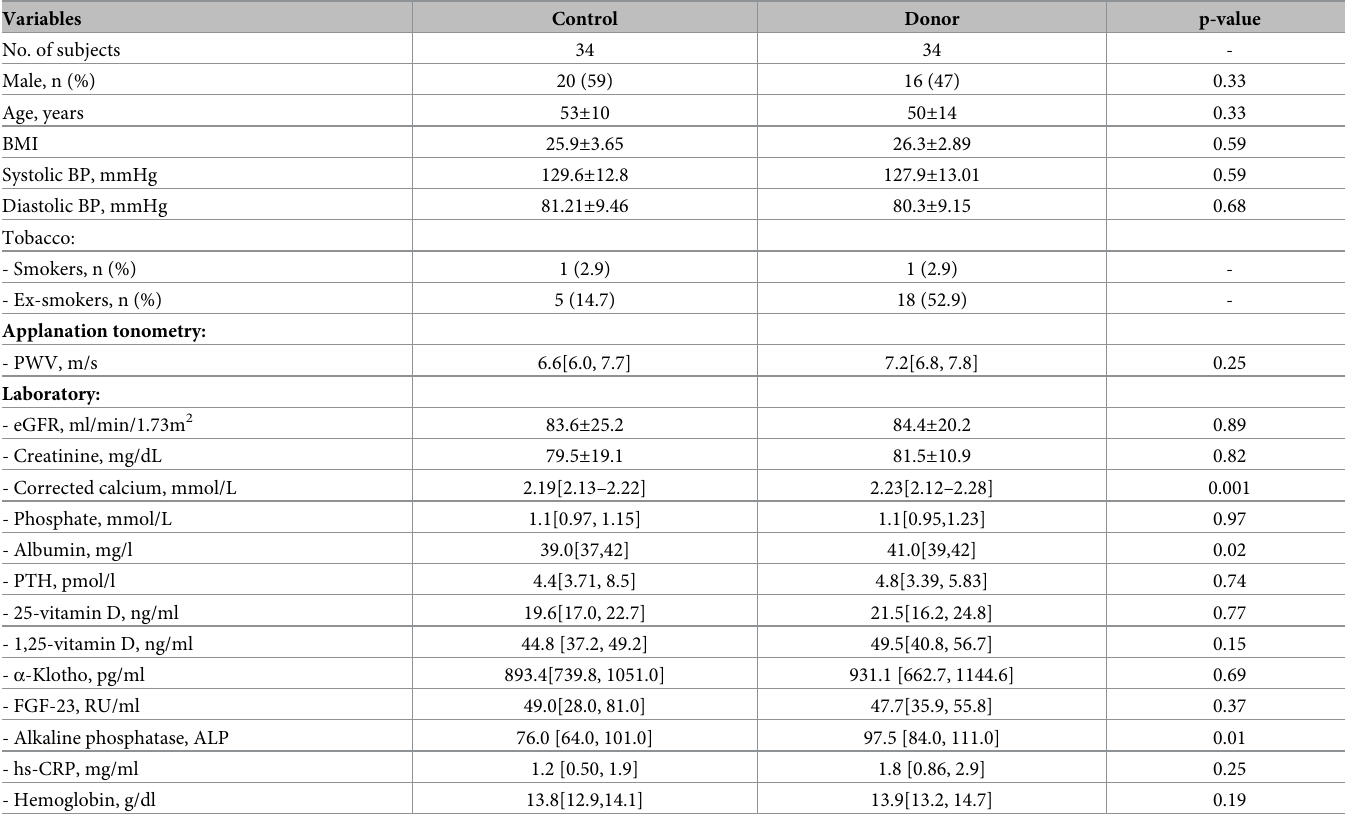
Table 1. Baseline